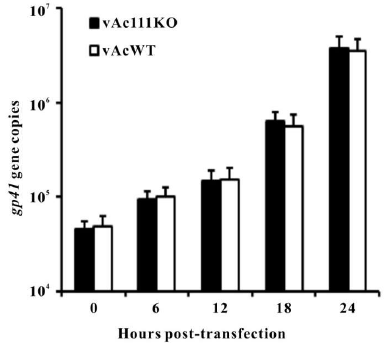
Figure 4. qPCR analysis of viral DNA synthesis in Sf9 cells. Sf9 cells were transfected with vAc111KO or vAcWT bacmid DNA. At the designated time points, total intracellular DNA was extracted, further digested with the restriction enzyme Dpn I to eliminate input bacmid DNA, and quantified by qPCR. The values represent the average of three independent replication assays. The error bars indicate standard